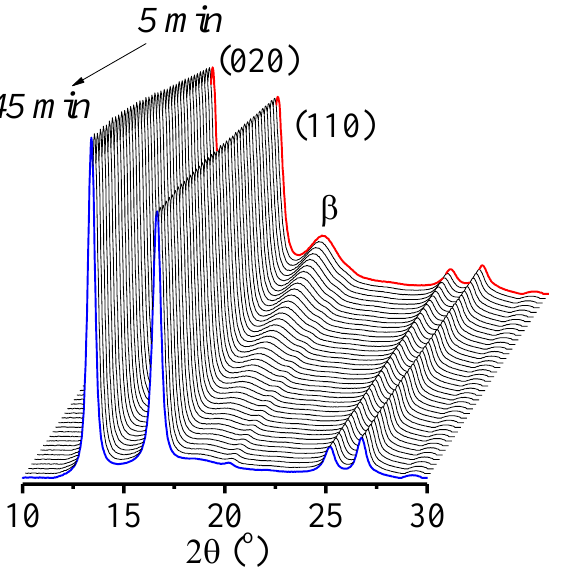
Figure 3. Equatorial line of the WAXD pattern of the two-step-drawn PHBV film observed during annealing at 130 °C.